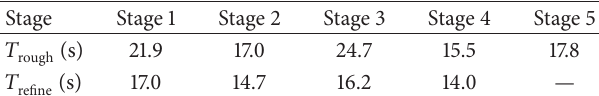
Table 8: Computation time in each stage (Case 2).